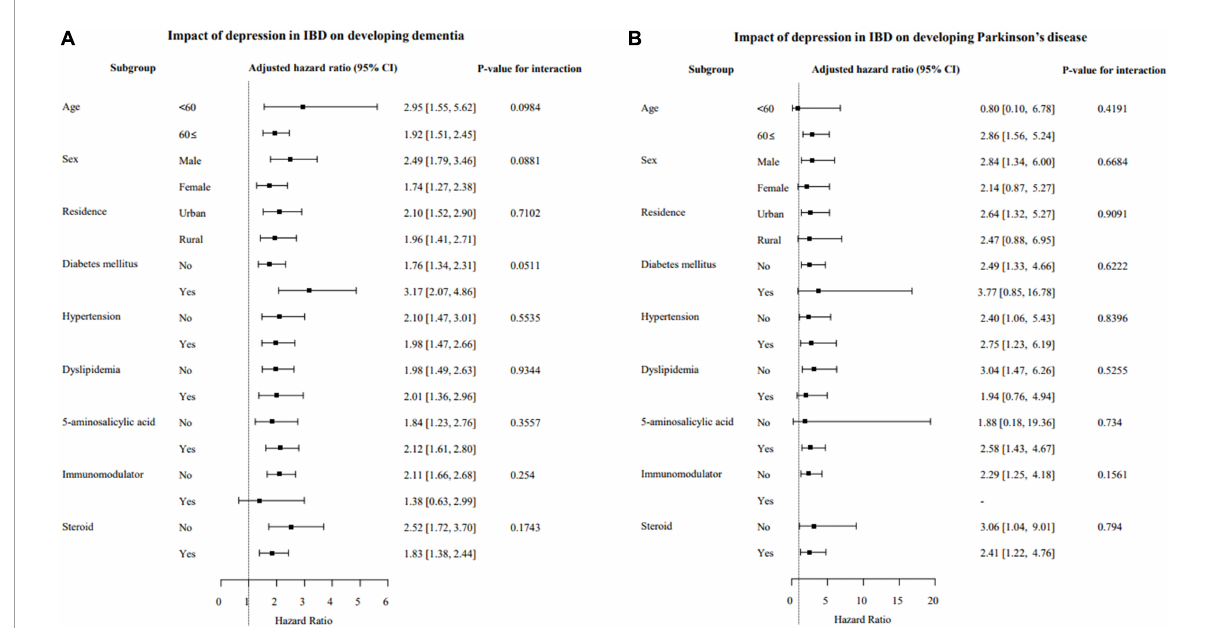
FIGURE2 Subgroup analysis of the risk of developing dementia (A) and Parkinson’s disease (PD) (B) based on the presence of depression in patients with IBD. IBD, inflammatory bowel disease; CI, confidence